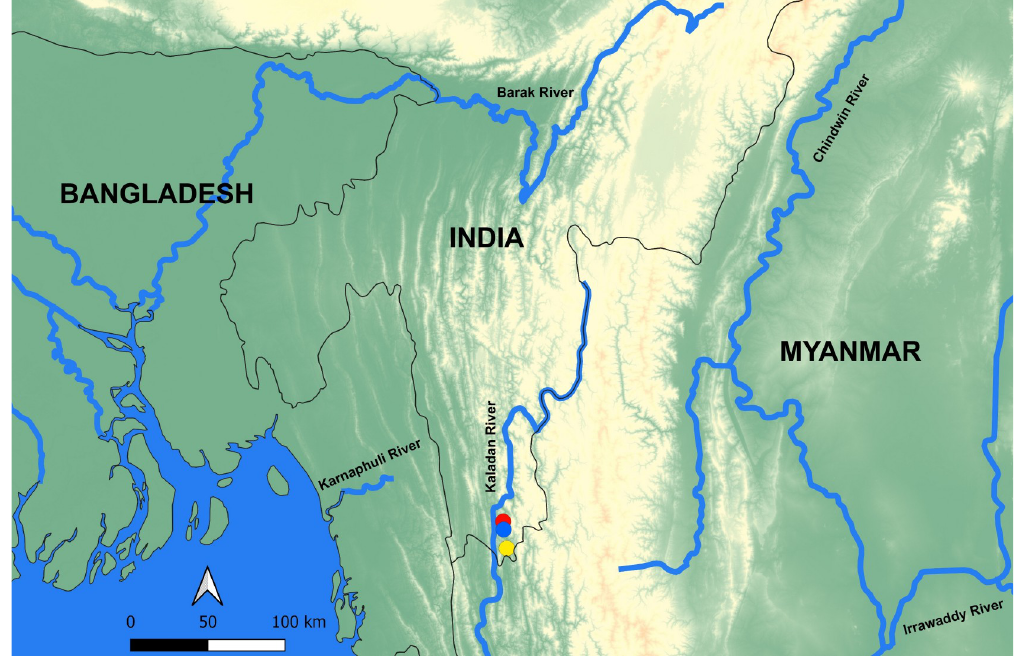
Fig 6. Map showing collection locality of Badis kaladanensis in the form of coloured dots. Red color dot represents Palak River in the vicinity of Phurra Village, Blue color dot represents Palak River in the vicinity of Palak Lake and yellow color dot represents Sala River in the vicinity of Lungpuk